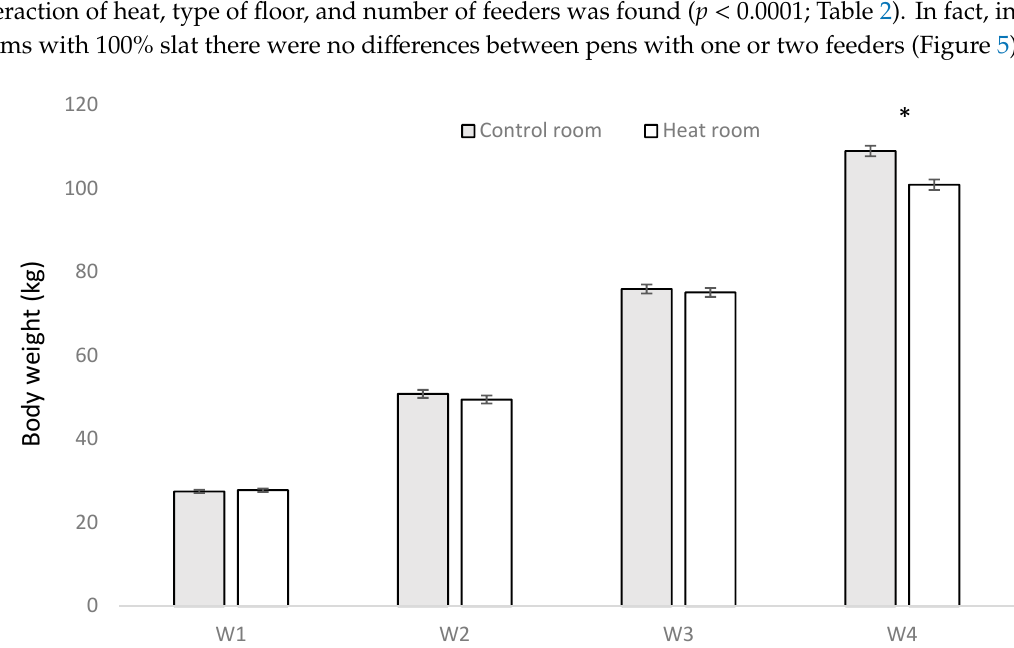
Figure 4. Mean ± SE of pig body weight per period (W1, W2, W3, and W4) comparing heat and control rooms. * means significant differences at p < 0.05.